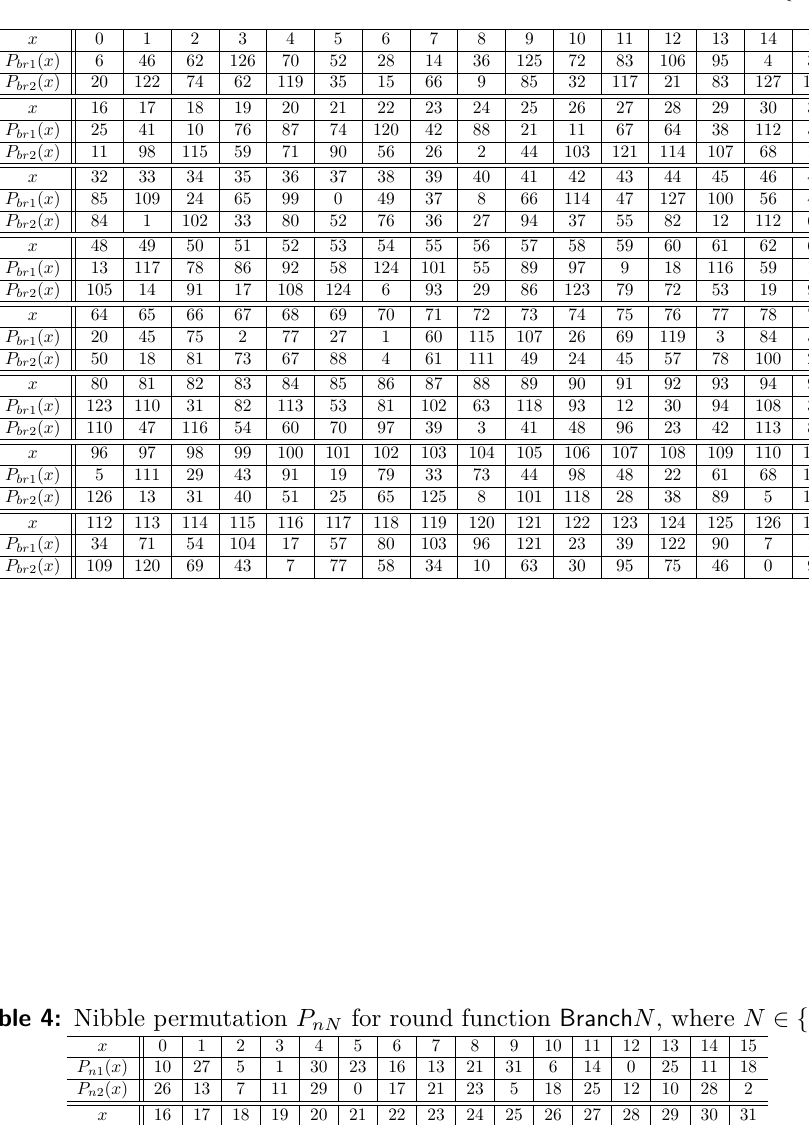
Table 3: Bit permutation P brN for round function Branch N , where N ∈ { 1 , 2 } .